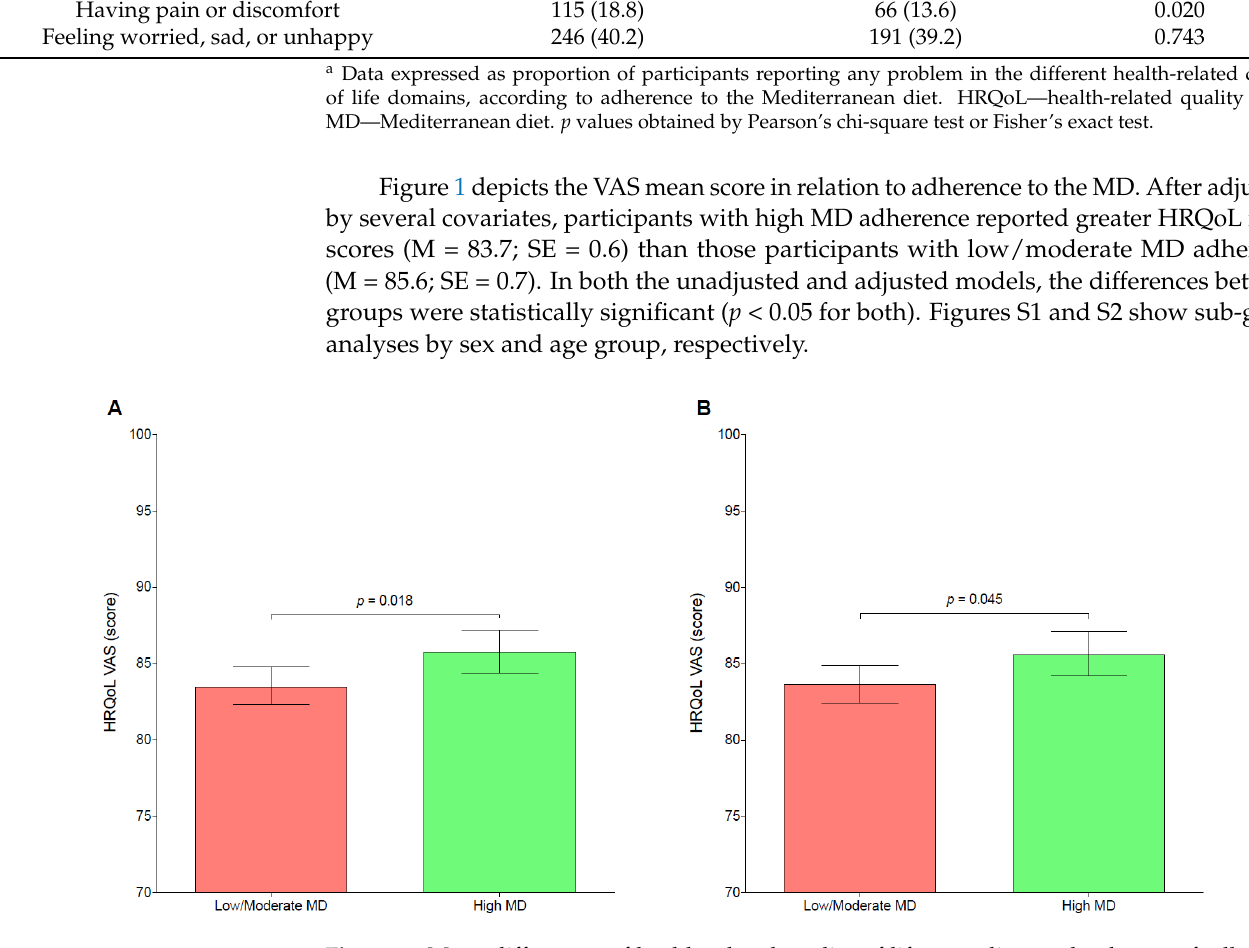
Figure 1. Mean differences of health-related quality of life according to the degree of adherence to the Mediterranean diet during the COVID-19 lockdown. HRQoL — health-related quality of life; MD — Mediterranean diet; VAS — visual analogue scale. ( A ): unadjusted; ( B ): adjusted by sex, age, nationality, socioeconomic status, breadwinner’s educational level, excess weight, and daily movement behaviors. p values obtained by analysis of covariance. Table 3 indicates the association between different MD components of the